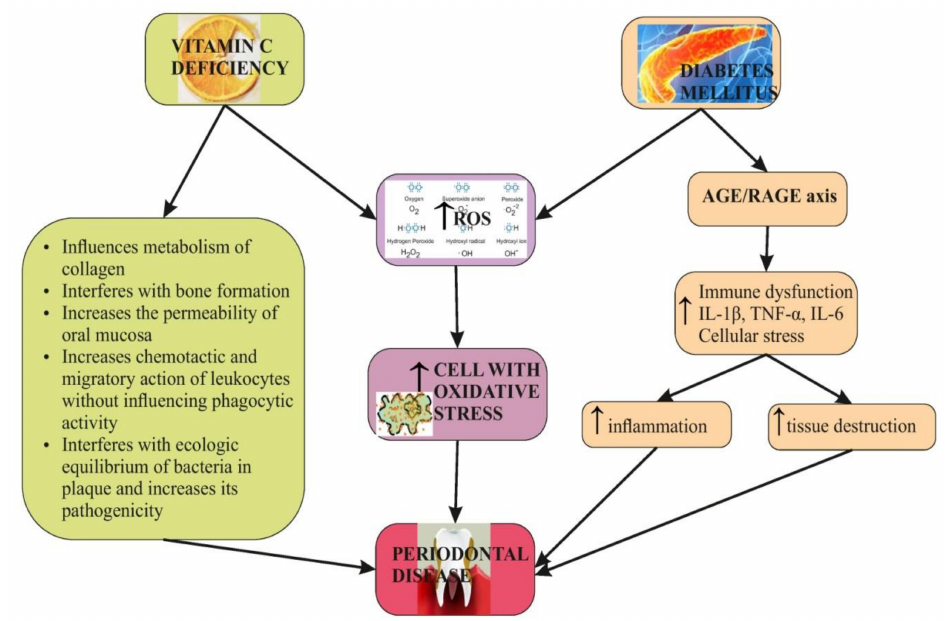
Figure 1. The interrelation between vitamin C, diabetes mellitus (DM) and periodontal disease